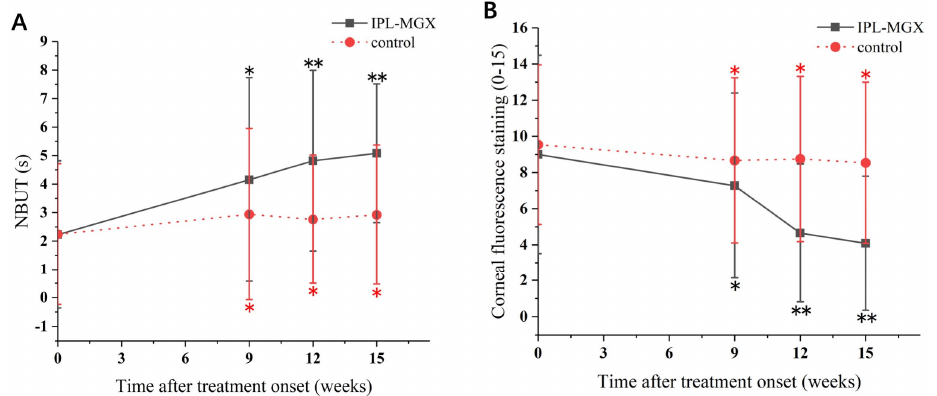
Figure 3. Time course of non–invasive tear breakup time (NBUT) and corneal fluorescein staining (CFS) in the intense pulsed light (IPL)–meibomian gland expression (MGX) and control groups. ( A ) Changes of NBUT before and after treatment. ( B ) Changes of CFS before and after treatment. All follow–up assessments were compared to the baseline (time 0) values (* p < 0.05, ** p < 0.001).